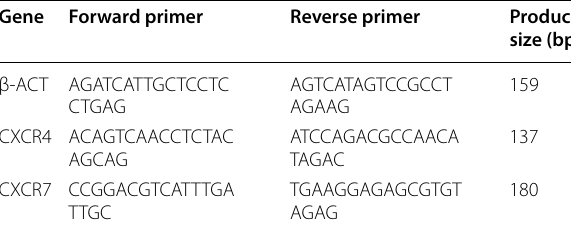
Table 1 Information of the primers used in this study Gene Forward primer Reverse primer Product